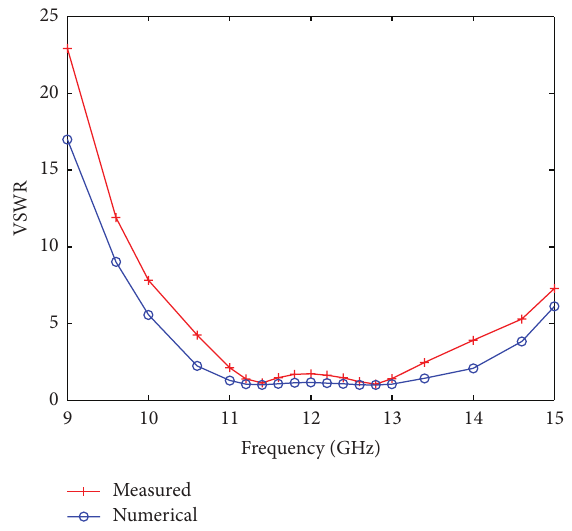
Figure 5: VSWR versus frequency plot of calculated and measured results of proposed antenna.